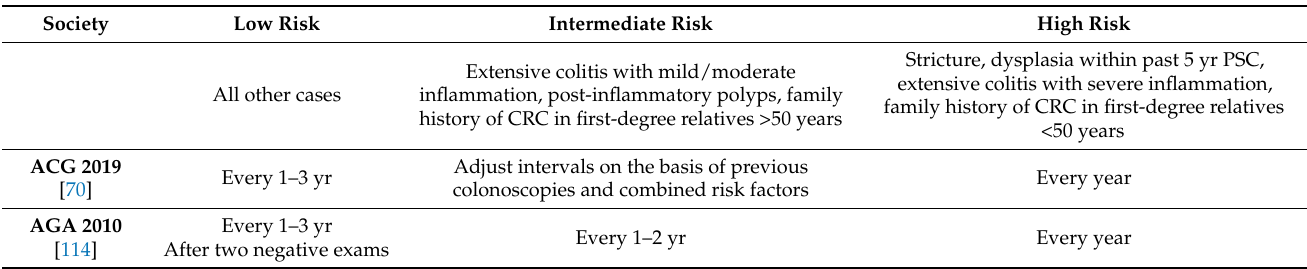
Table 2. Societal recommendations for endoscopic